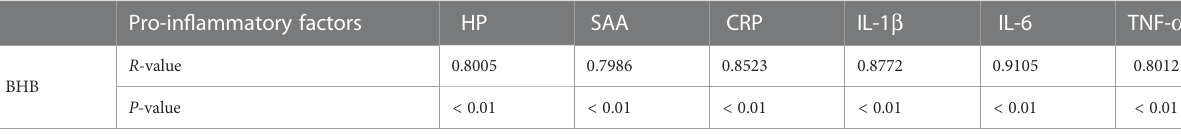
TABLE 2 Correlation analysis between concentrations of pro-in fl ammatory factors and BHB in serum. Pro-in fl ammatory